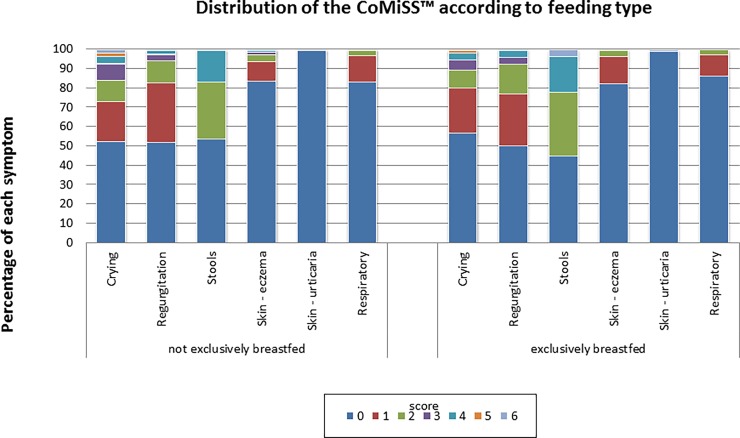
Distribution of CoMiSS according to feeding.